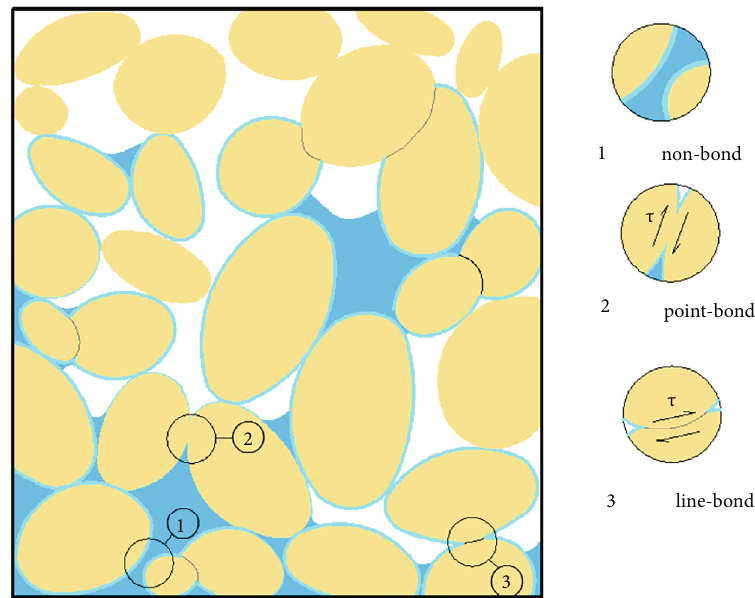
Figure 8: Porous medium mechanical model of mudstone.